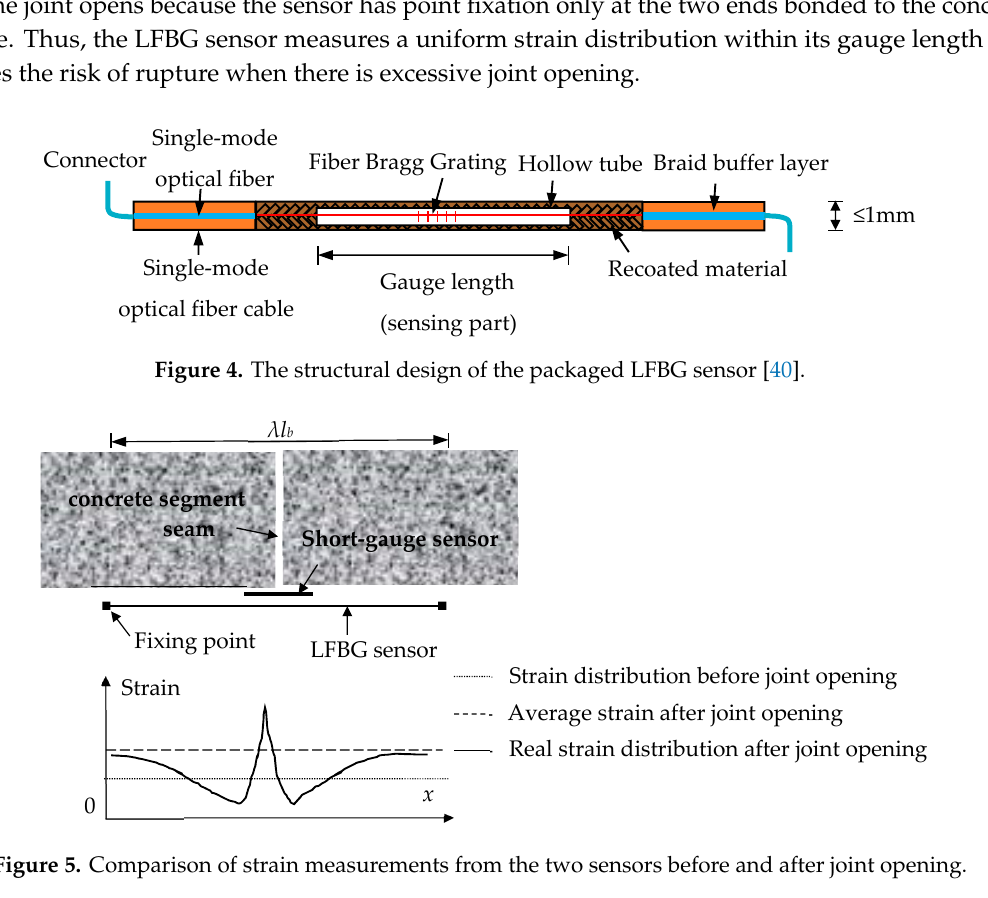
Figure 5. Comparison of strain measurements from the two sensors before and after joint opening.